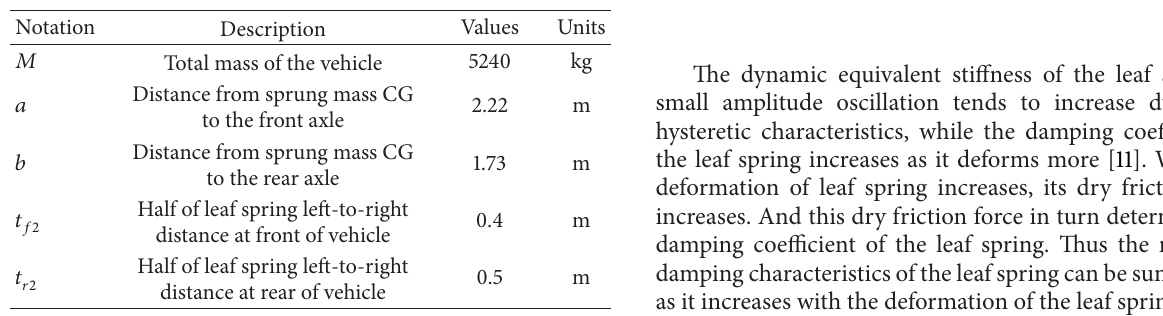
Figure 7: Comparison of the vertical acceleration of testing with the one of simulation in bounce